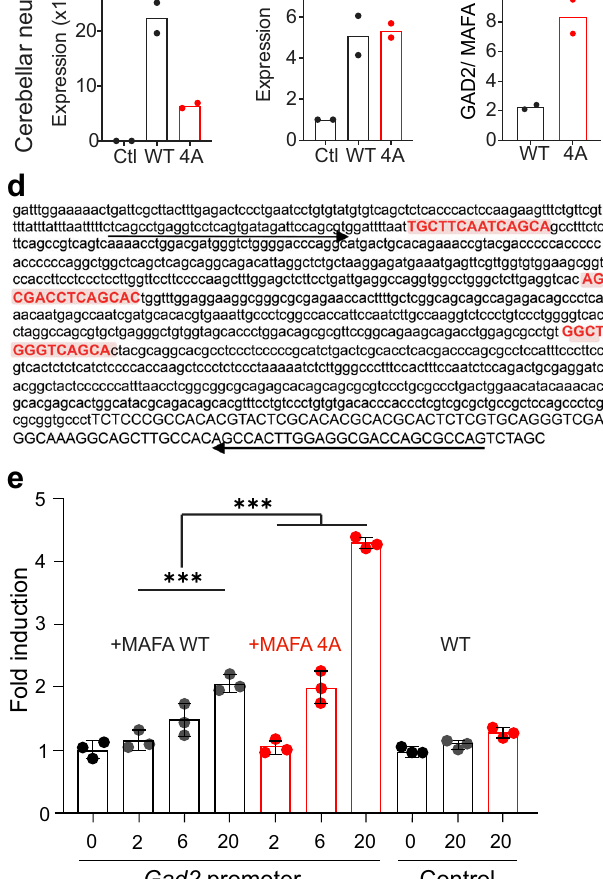
Fig. 5 Gad2 is a direct target of the Mafa transcription factor. a Gad2 in situ hybridization (black) combined with anti-bgal staining (red) on P0 transverse sections of the caudal medulla of section of Mafa LacZ/ + (left) and Mafa LacZ/LacZ (right) pups. Note the reduced Gad2 signal surrounding β gal + nuclei in the absence of Mafa. Data from three mice for each genotype. In DAOY medulloblastoma cell line ( b ) or primary culture of granule cell progenitors ( c ) that do not express MAFA (Ctl, left plots in b and c ), transfection with either MAFA WT or MAFA 4A yields MAFA expression (left plots) that induces GAD2 transcription (middle plots). The right panel shows the fold induction of GAD2 , compared to MAFA expression ( n = 2 biological replicates each with n = 3 technical replicates). d The Gad2 promoter (878nt upstream of Gad2 transcription start, in between oligos used to clone Gad2 promoter in pGL3) contains MAF Responsive Elements (MARE, red boxes). e Luciferase assays in DAOY cells reporting Gad2 promoter (left) and control luciferase activity (right) when co-transfected with increasing doses of plasmids encoding MAFA WT or MAFA 4A. All assays were performed in triplicates. Two-way ANOVA was used to test that MAFA enhances Gad2 promoter activity in a dose-dependent manner ( P < 0.0001, df = 3; F = 218.4) and that MAFA 4A induces